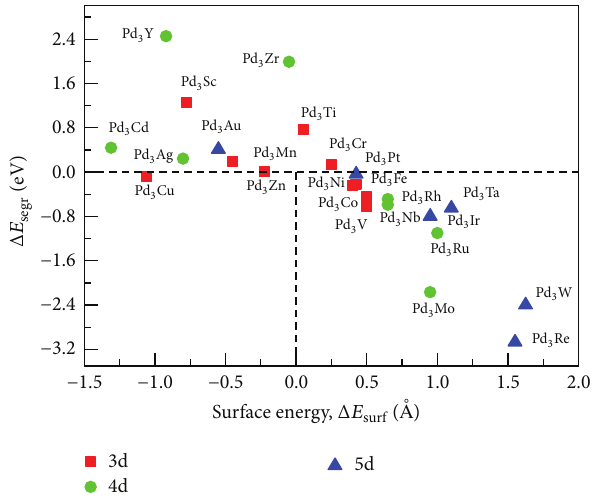
Figure 4: Plots of DFT-calculated segregation energy ( Δ𝐸 Pd in Pd 3 M alloys as functions of experimental surface energies of alloying metals (M). Surface energies are given with respect to that = 𝐸 ( M ) − 𝐸 ( Pd ) of Pd; that is, Δ𝐸 surf surf surf